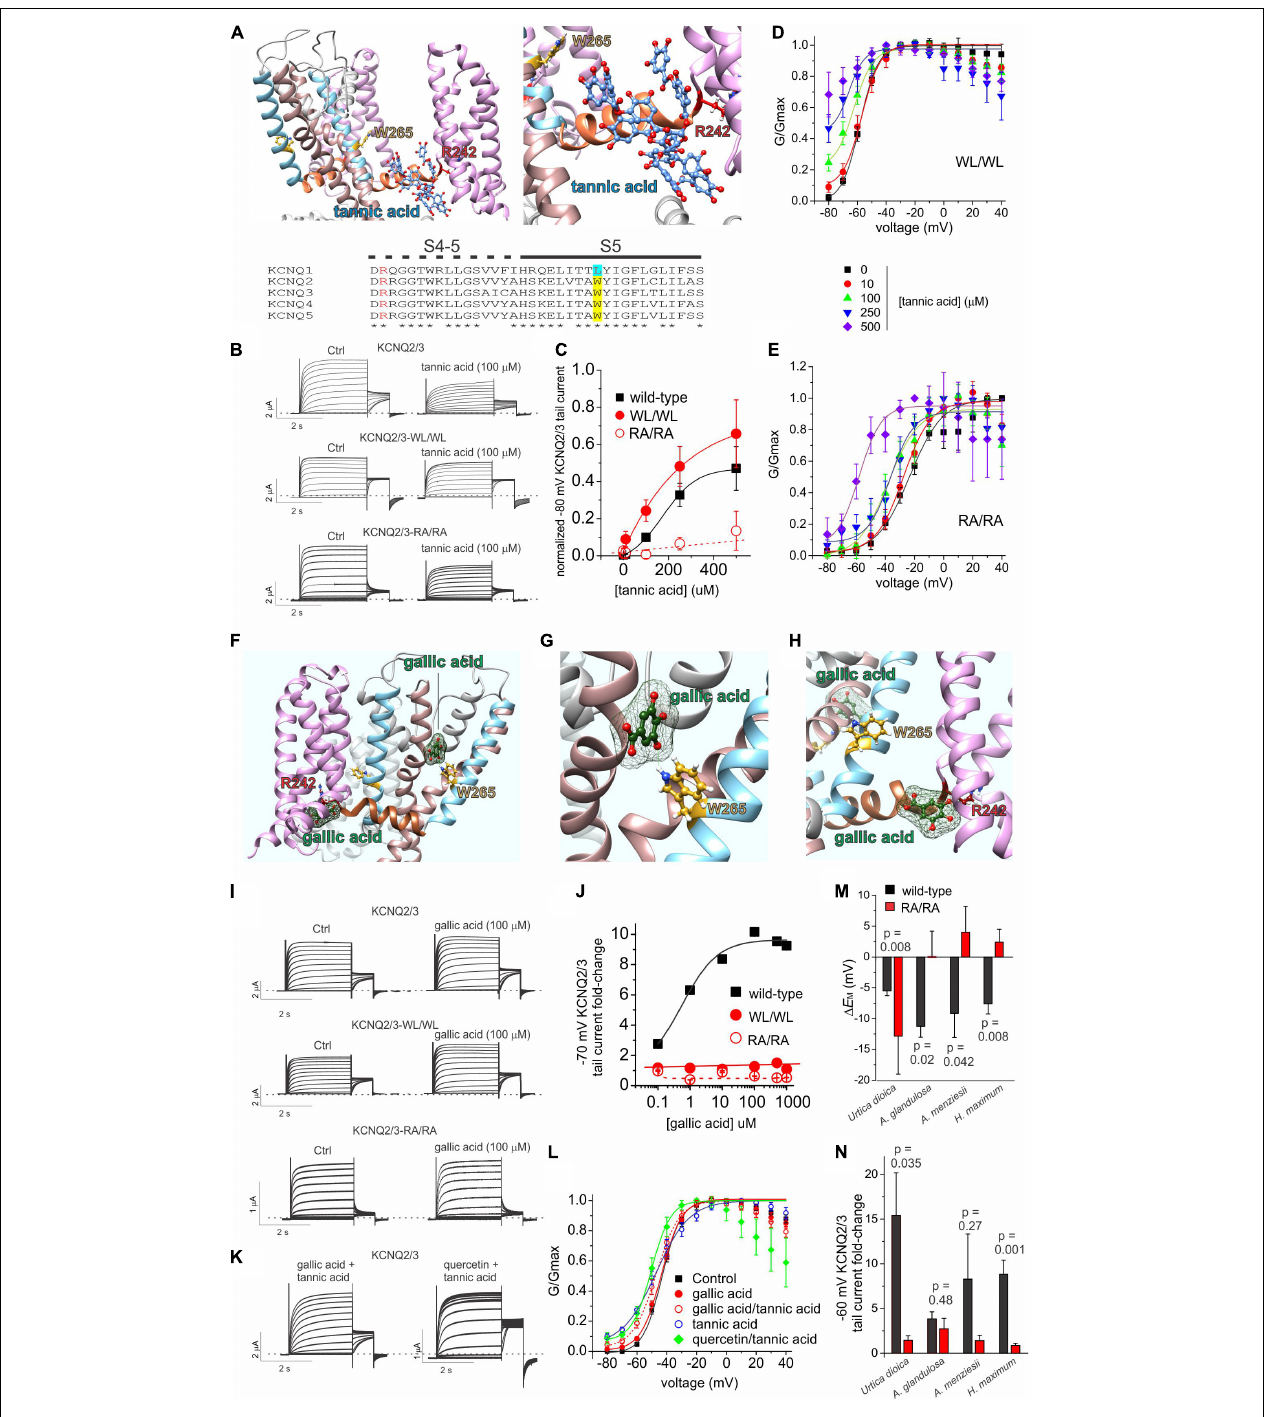
FIGURE 8 | Tannic acid and gallic acid in silico docking and mutagenesis. All error bars indicate SEM. n = number of oocytes. (A) In silico docking by SwissDock showing predicted binding pose for tannic acid in KCNQ2 ( left , far view; right , close-up). Lower inset , sequence alignment of human KCNQ channel isoforms in the S4-5 linker and S5 regions. Alignment colors: Red, KCNQ3-R242 and equivalents; yellow, KCNQ3-W265 and its equivalents in KCNQ2, 4 and 5; Cyan, KCNQ1-L266. (B) Exemplar TEVC traces of oocyte-expressed wild-type and mutant KCNQ2/3 in the absence (control) and presence of tannic acid (100 µ M). (C) Mean tail current after a –80 mV prepulse, normalized to maximal tail current, for wild-type and mutant KCNQ2/3 channels as in panel (B) . Wild-type, n and source data as in Figure 6B ; WL/WL, n = 5–6; RA/RA, n = 5–8, except 500 µ M: n = 4. (D) Mean normalized tail currents (G/Gmax) versus prepulse voltage relationships for WL/WL traces as in panel (B) at various tannic acid concentrations ( n as in panel C ). (E) Mean normalized tail currents (G/Gmax) versus